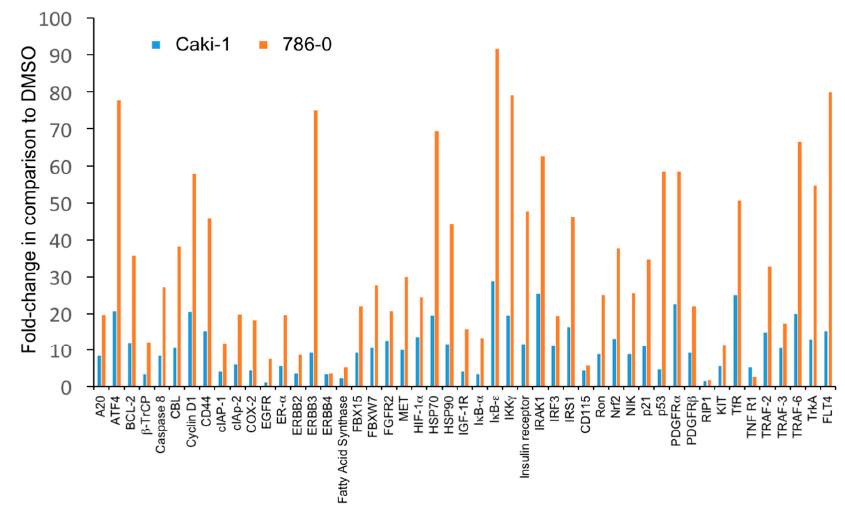
Figure 5. Antitumoral effects of carfilzomib correlate with the level of accumulation of ubiquitinated proteins. Quantification of fold-changes of ubiquitinated proteins in Caki-1 cells and 786-0 cells after treatment with 10 μ M carfilzomib or control (0.1% DMSO) for 6 h. Results were normalized to DMSO and corrected for background. Note the higher accumulation of ubiquitinated proteins in 786-0 cells. Results from a representative experiment are shown.